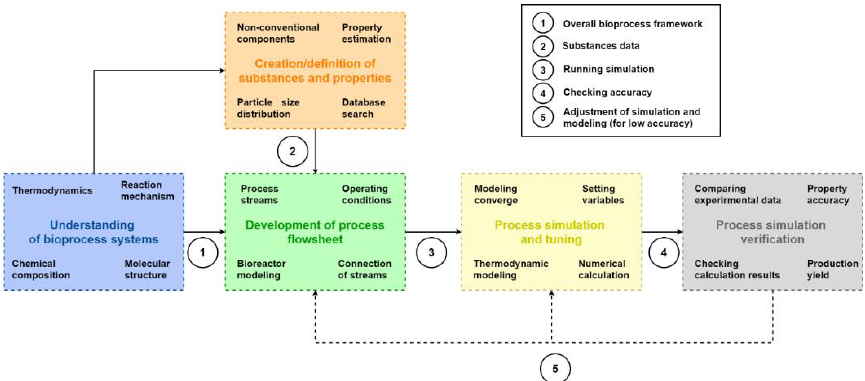
Figure 3. An illustration of an implemented step-wise procedure in the simulation and modeling of emerging bioprocesses.